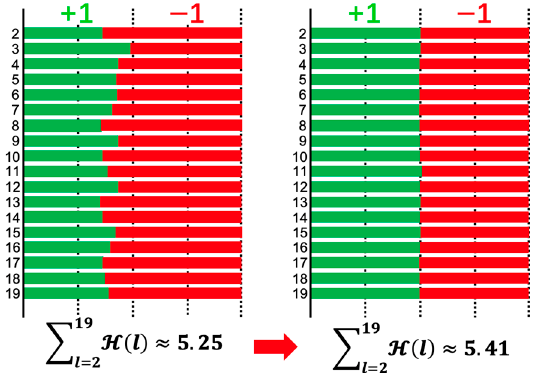
Figure 4. The distributions of network activations’ binary representations (±95% confidence inter- val) without/with BMA ( left / right ) in binary pre-activation XNOR-Net/ResNet-20 are illustrated. The models are trained on the CIFAR-10 dataset.